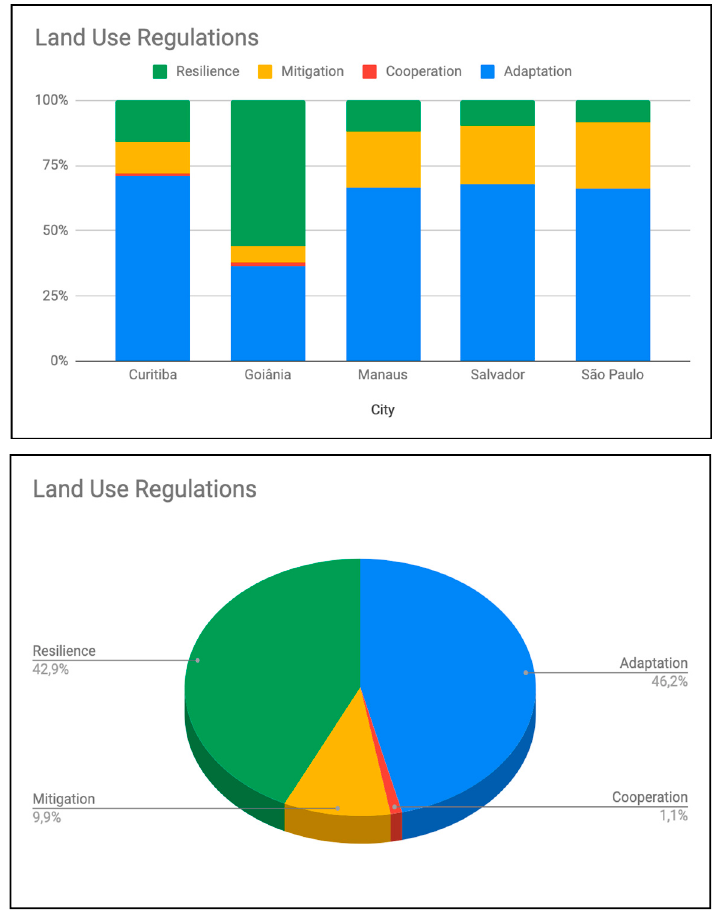
Figure 9. Climate action references in city land use regulations.